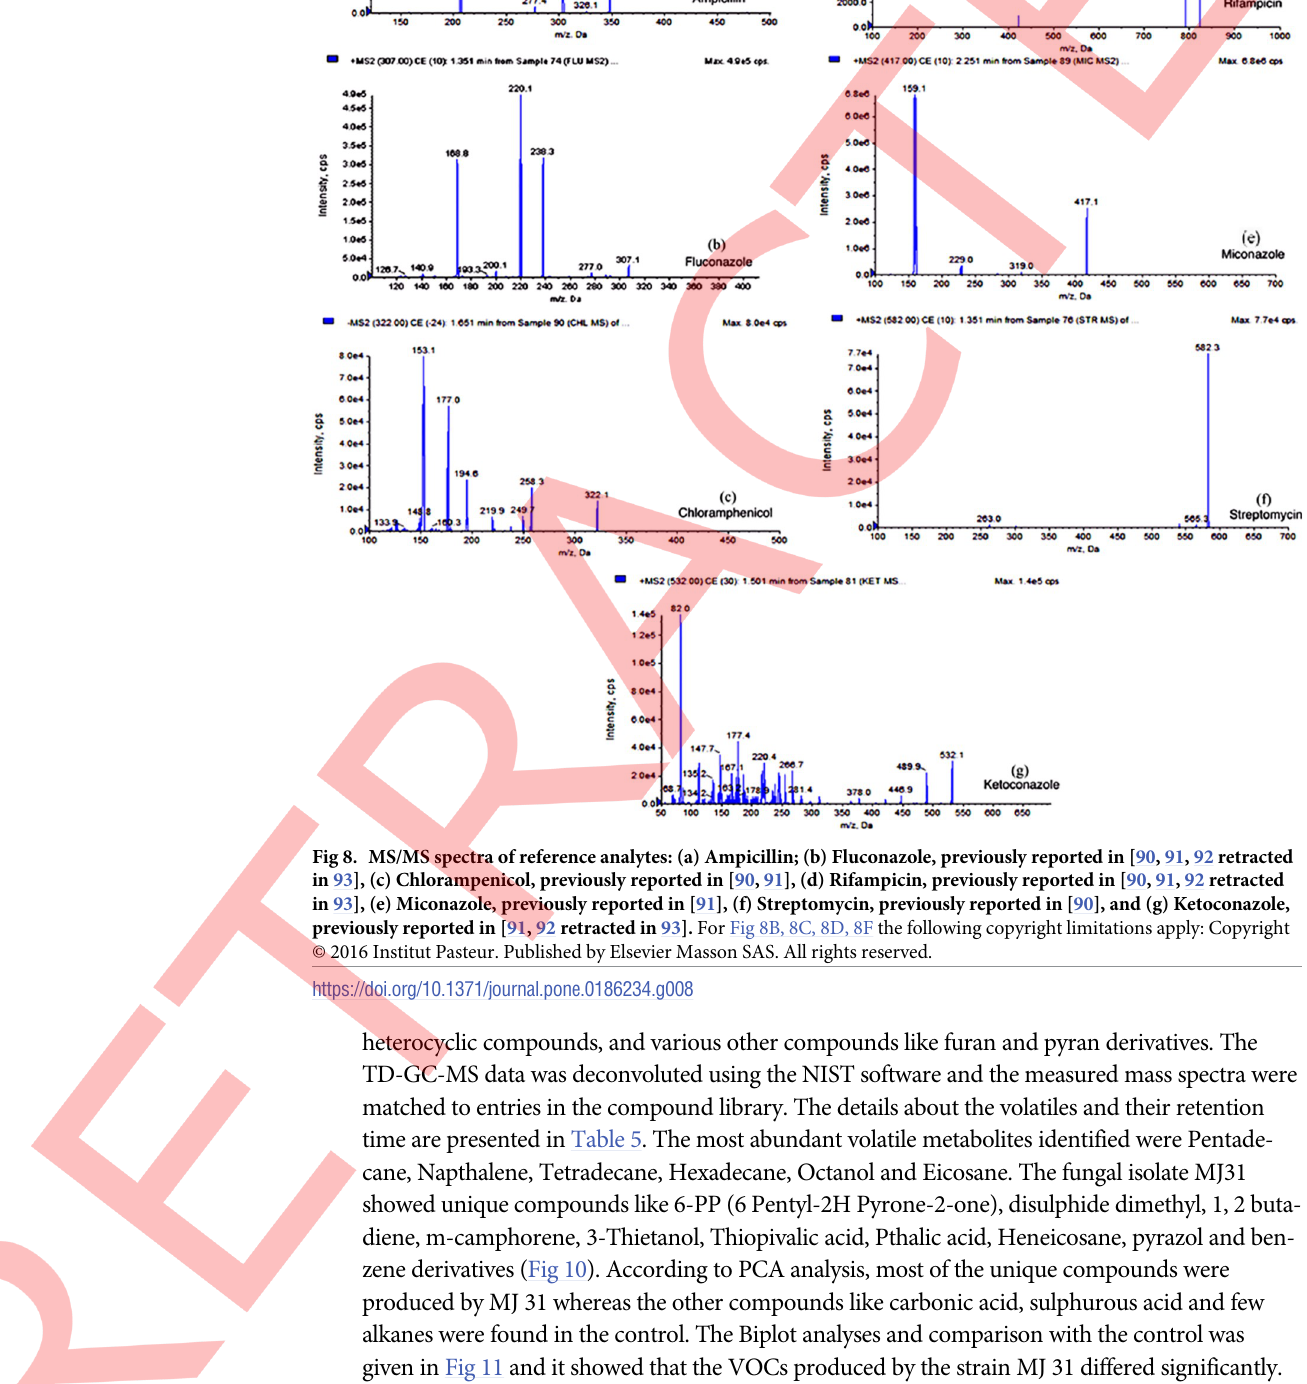
given in Fig 11 and it showed that the VOCs produced by the strain MJ 31 differed significantly.